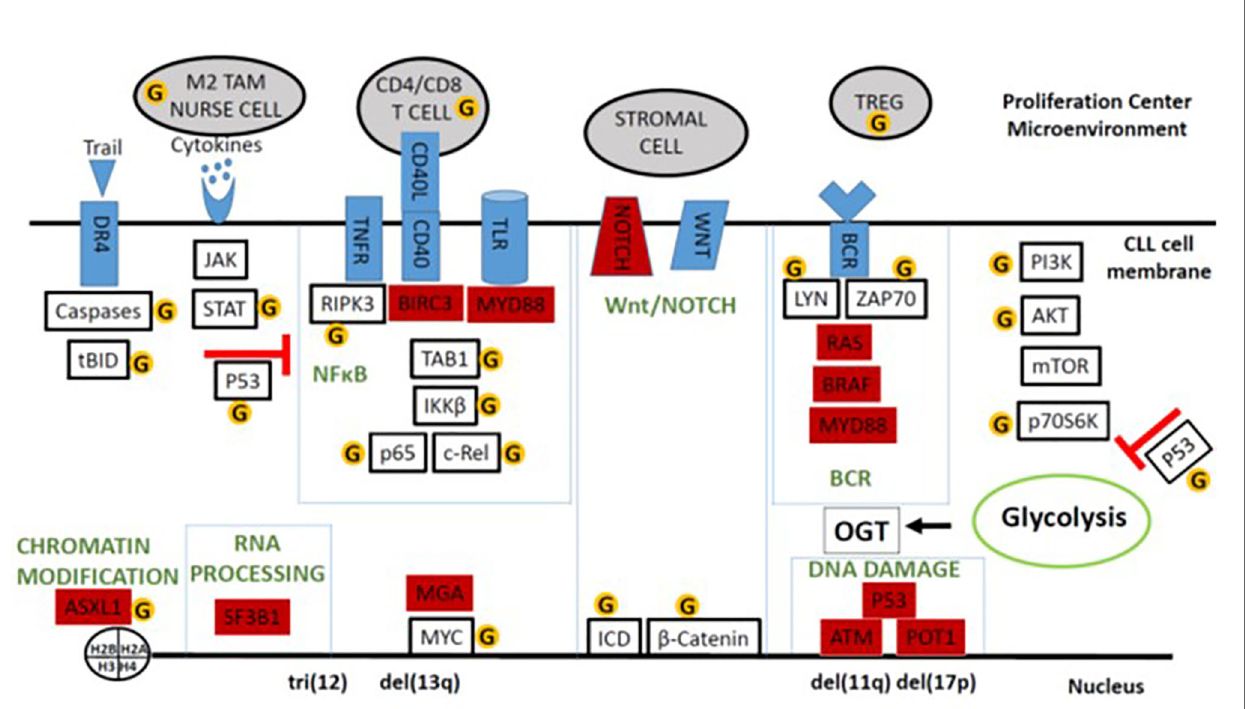
FIGURE 2 | Schema of O-GlcNAcylated oncogenic processes in the CLL microenvironment. Major signaling and system modules that drive growth and progression of CLL cells are organized in the boxes along with important auxiliary pathways like cytokine- and AKT-signaling. Genes frequently mutated in CLL are colored in red. Proteins and cells discussed in the text that can be affected by O-GlcNAcylation are indicated by the yellow circled G ’ s. The fi gure emphasizes that O-GlcNAcylation increases the tumor-suppressing activity of wild-type p53 but enhances many of the signaling processes that support tumor growth in the presence of mutant p53 and an impaired p53